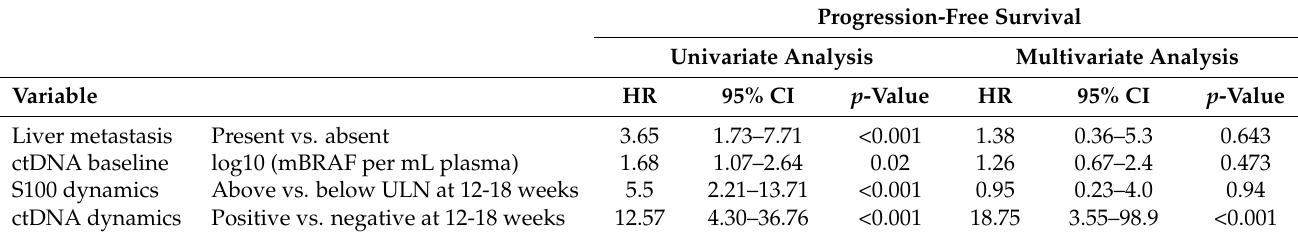
Table 2. Factors associated with the progression-free survival (PFS). HR = hazard ratio, 95% CI = 95% confidence interval, ULN = upper limit of